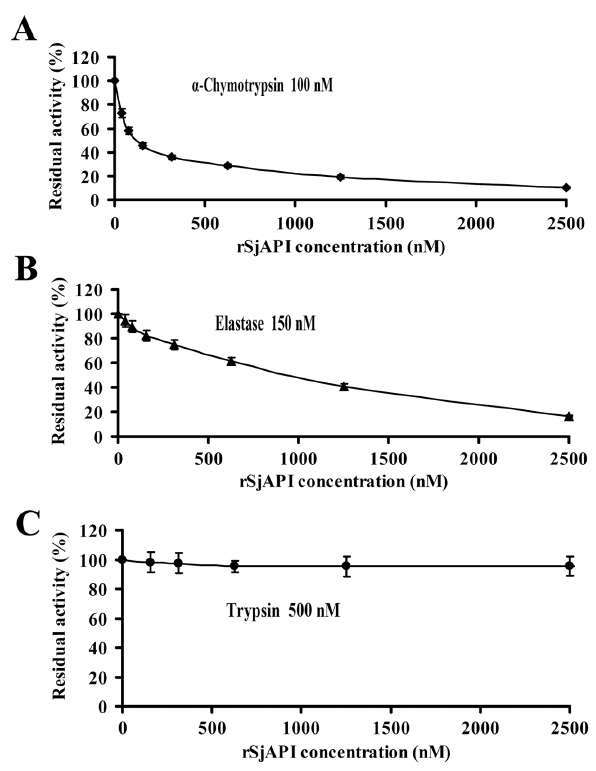
Figure 4. Serine protease inhibitory activities of rSjAPI with different concentrations. (A) The concentration dependence of inhibitions on trypsin was shown with different concentrations of rSjAPI. (B) The concentration dependence of inhibitions on a - chymotrypsin was shown with different concentrations of rSjAPI. (C) The concentration dependence of inhibition on elastase was shown with different concentrations of rSjAPI. Trypsin (final concentration 500 nM), a -chymotrypsin (final concentration 100 nM), elastase (final concentration 150 nM) were each incubated with various concentra- tions of rSjAPI (0–2500 nM) for 30 min. All data represent the mean 6 standard error of at least three experiments.